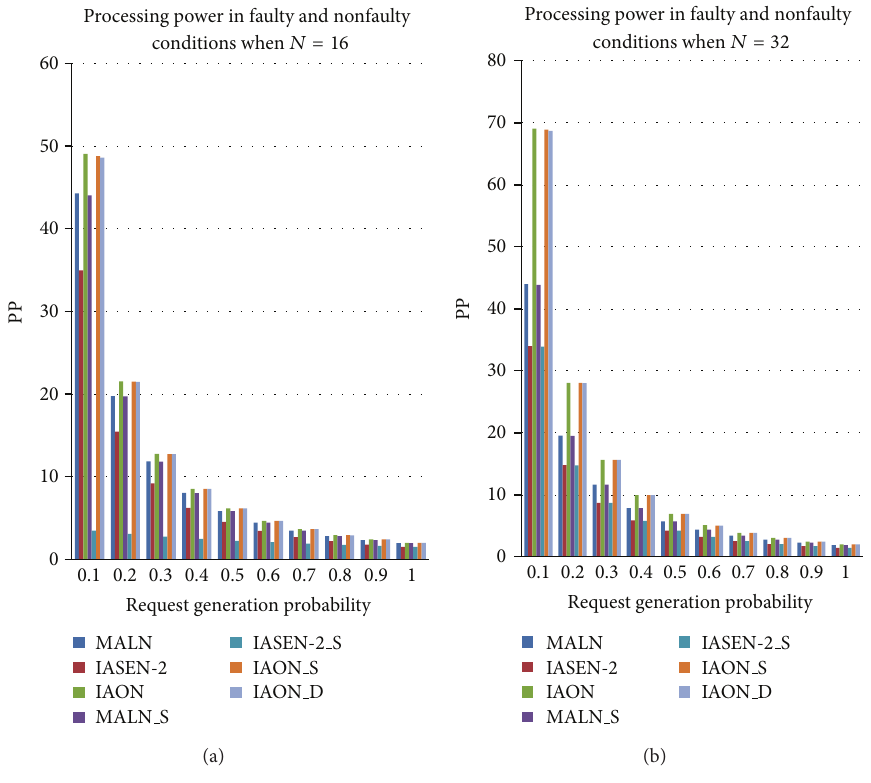
Figure14:TheprocessingpowerofMALN,IASEN-2,andIAONinfaultyand